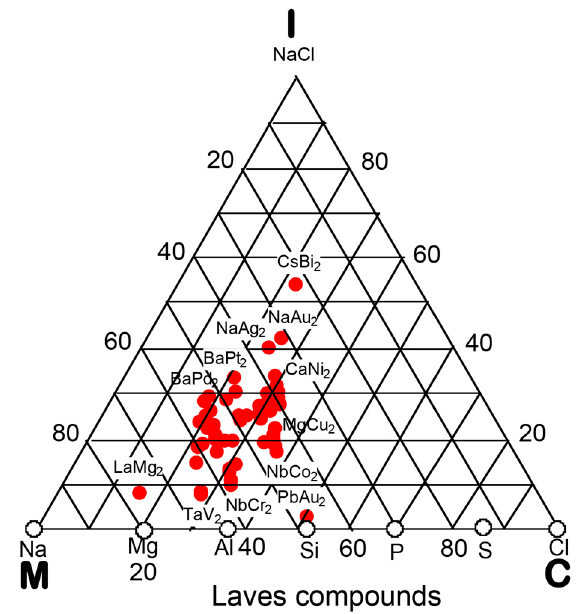
Figure 100. van Arkel-Ketelaar triangle map constructed by inserting the Allen electronegativity (see Table 2) into Equations (17) and (18) for 50 equiatomic compounds AB. This may be used as a guide to roughly envisage bond-styles of Laves compounds AB 2 .